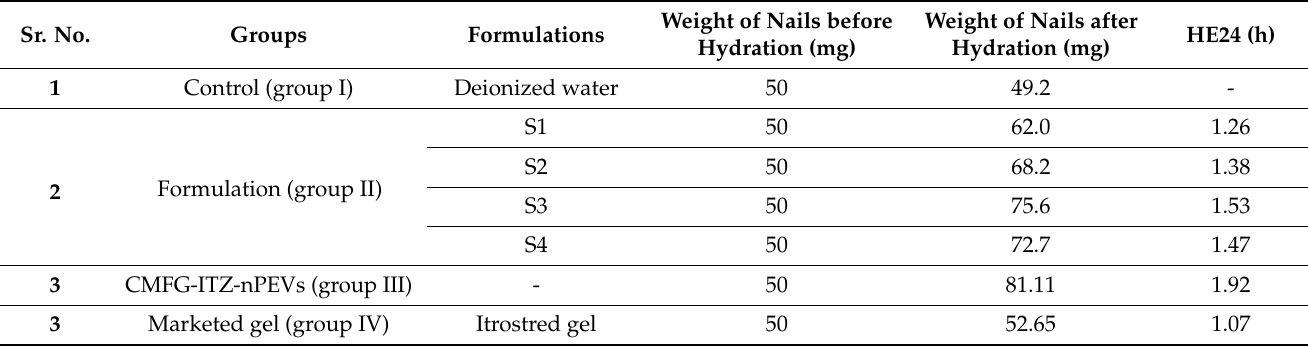
Table 4. Nail hydration study of various formulation.